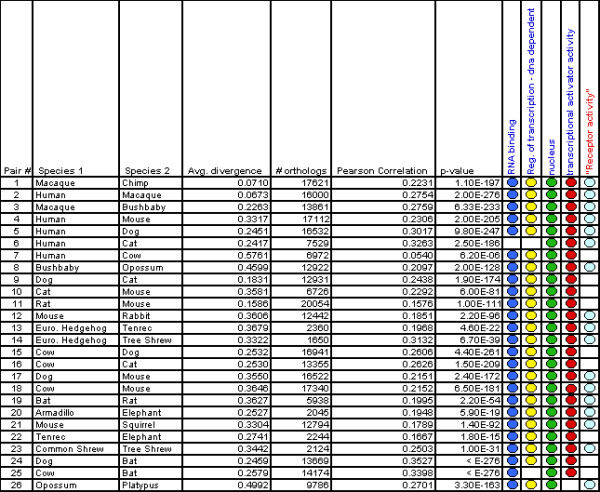
Pearson correlation of substitution rates between neighboring mammalian genes and evidence of selective pressures. 20 mammalian species and 26 species pairs are shown. In striking contrast to the fungi, every mammalian comparison gives a highly significant correlation between rates of neighboring genes (column 7). (Right) Similar types of genes have unusually low or unusually high silent substitution rates across the mammals, suggesting universal selection pressures. Genes in the categories RNA binding, regulation of transcription – DNA dependent, nucleus, or transcriptional activator activity (blue text) have unusually low silent substitution rates in virtually every mammalian species pair, as marked by ovals. Gene associated with receptor activity have unusually high silent substitution rates (red text) in most mammalian species pairs.